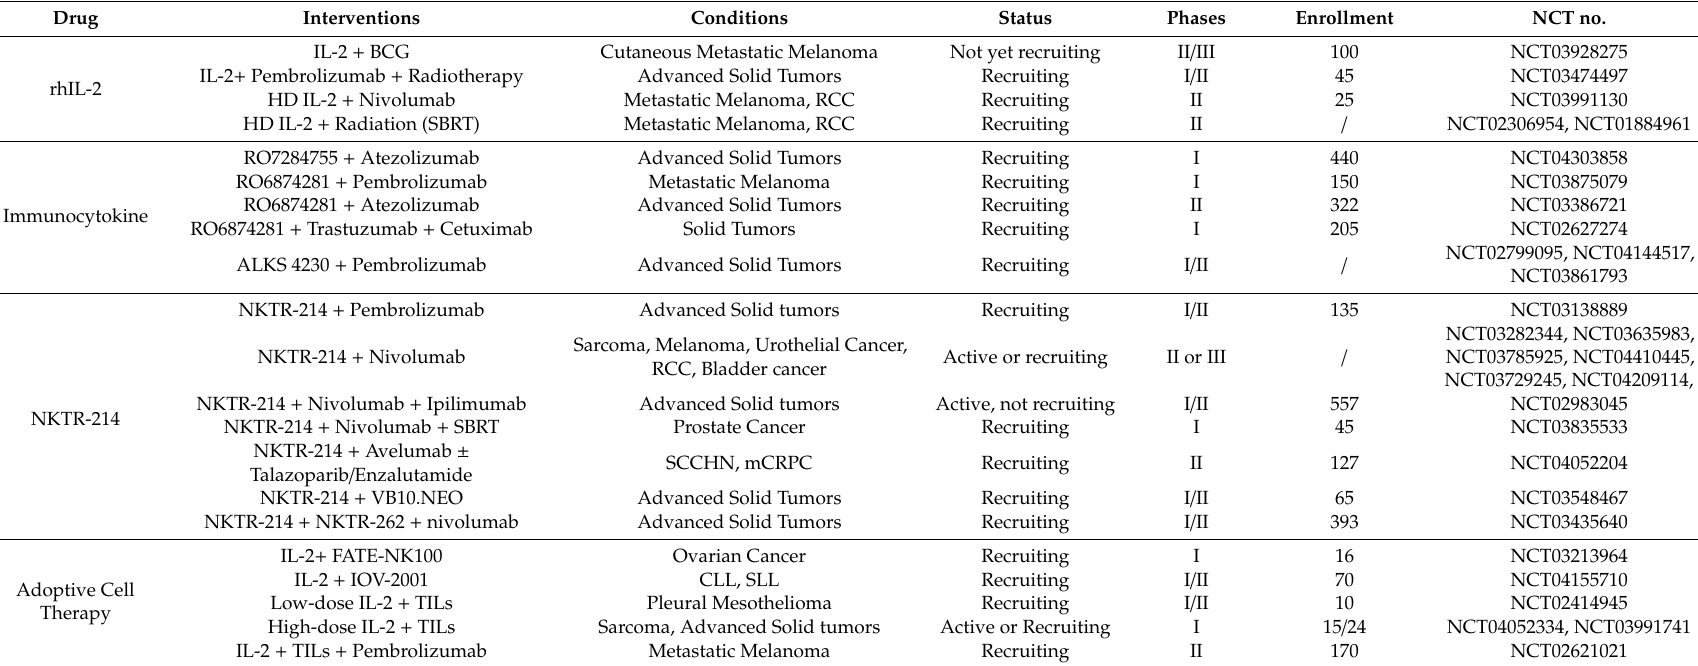
Table 1. Examples of ongoing clinical trials with